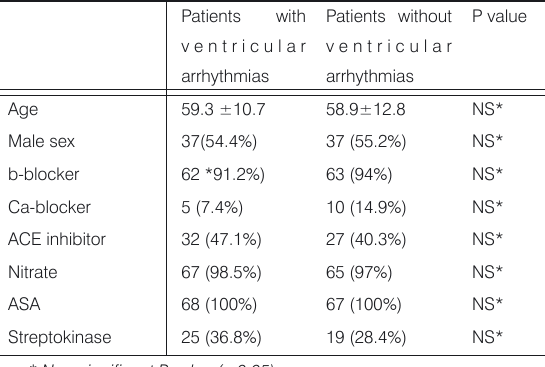
Table 1. Age, sex and different medications received by two study groups.